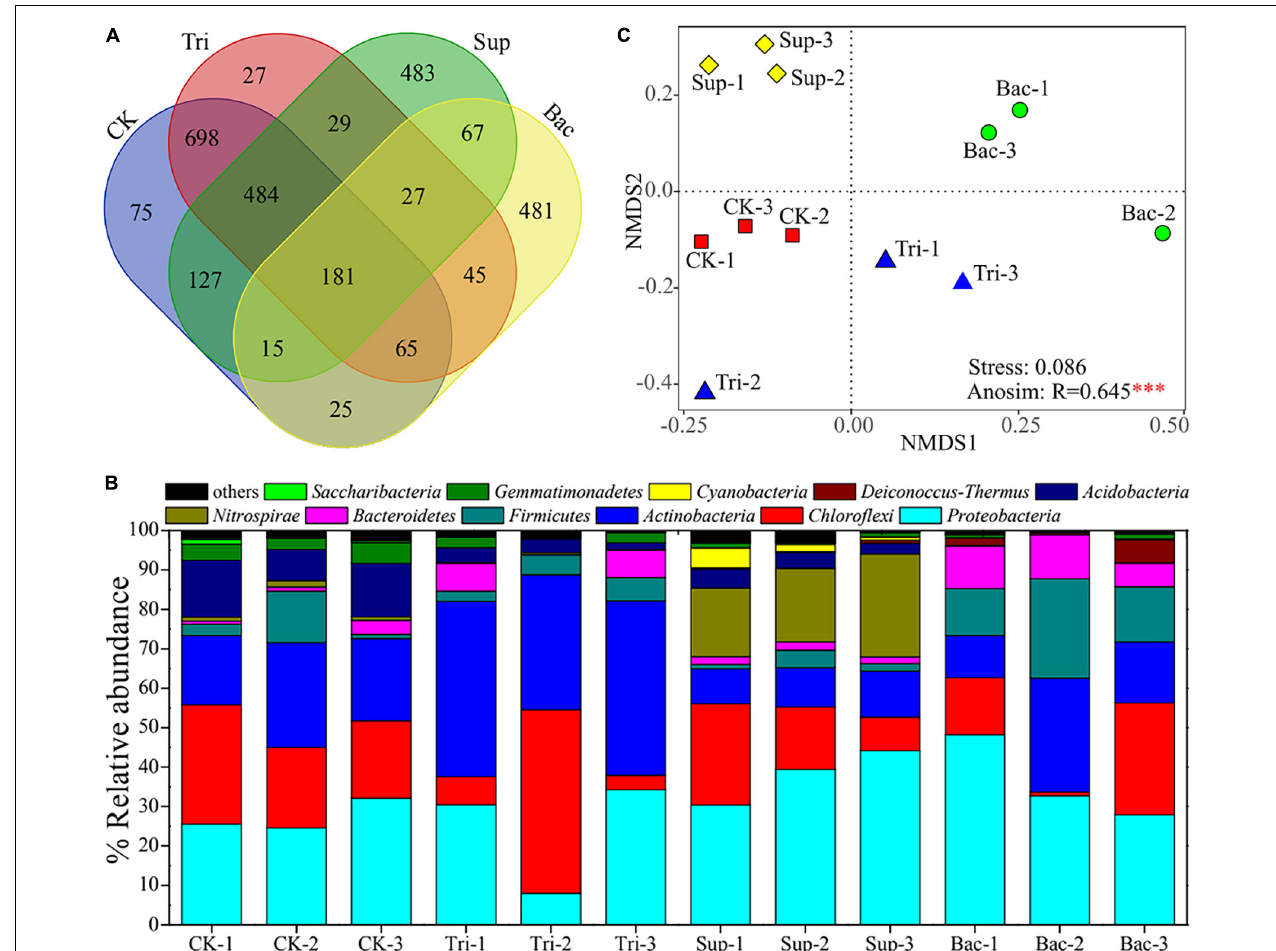
FIGURE 2 | Composition of rhizosphere bacterial community. (A) Venn diagram shows the shared core microbiomes among four groups. (B) Stacking diagram reflects relative abundances of top 11 bacterial phyla (relative abundance > 1%) in 12 soil samples. (C) Non-metric multidimensional scaling plot exhibits difference in bacterial community composition among four treatments. Asterisks denote significance ( ∗∗∗ p < 0.001).